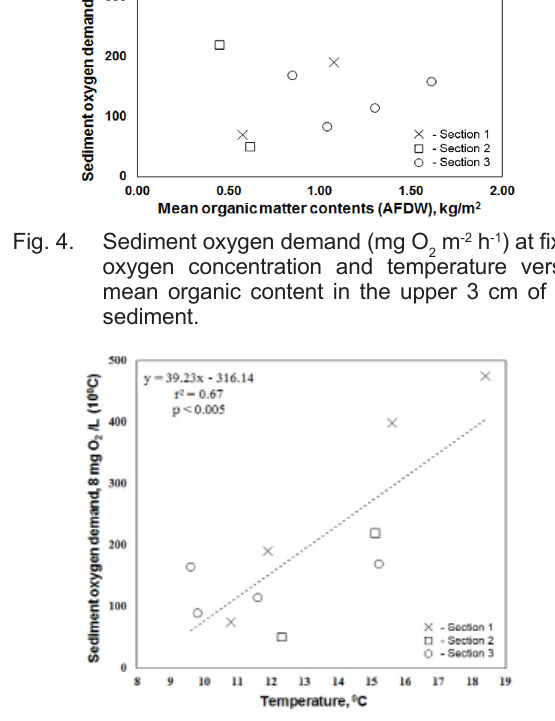
Fig. 5. Sediment oxygen demand (mg O oxygen concentration and temperature versus temperature in the streams.